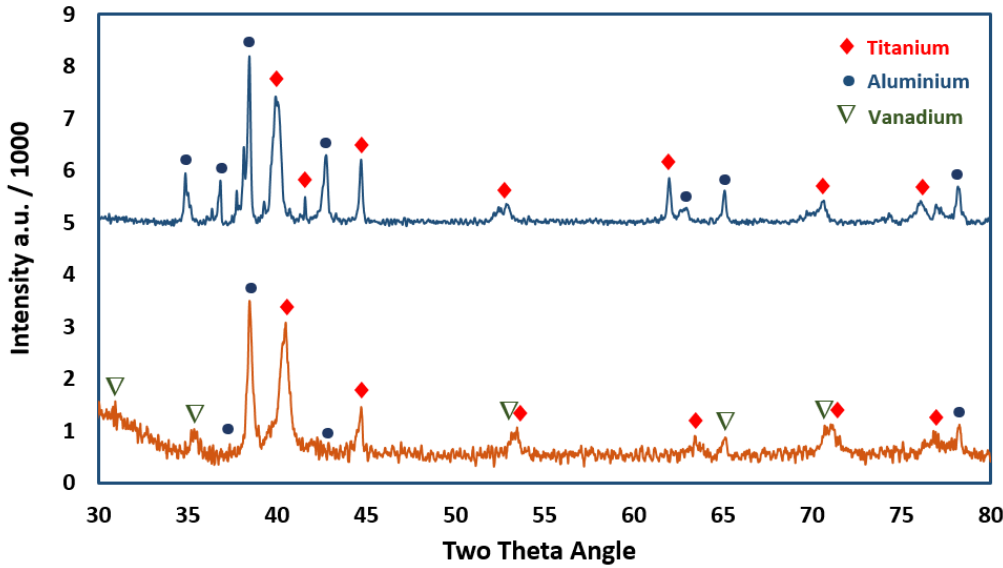
Figure 1. X-ray di ff raction (XRD) patterns of the Ti-6%Al (upper) and the Ti-6%Al-4%V (bottom) Figure 1. X-ray diffraction (XRD) patterns of the Ti-6%Al (upper) and the Ti-6%Al-4%V (bottom) alloys, alloys, respectively.